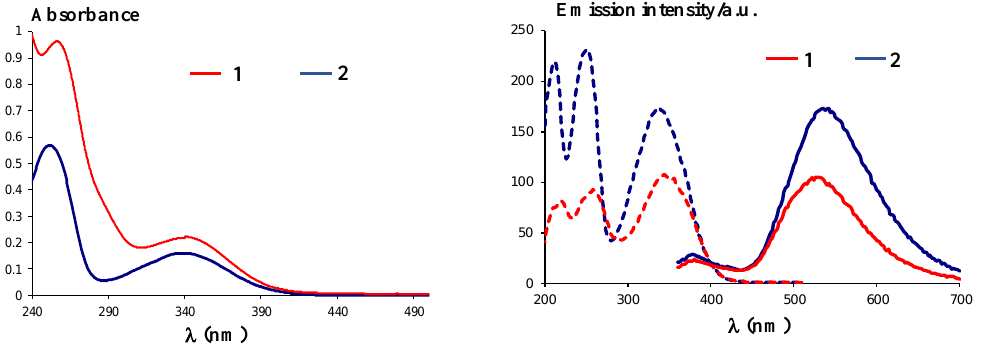
Figure 7. Left: UV-Vis spectra of compounds 1 and 2 in ethanol; right: Excitation (dotted lines) and emission (plain lines) spectra of compounds 1 and 2 .